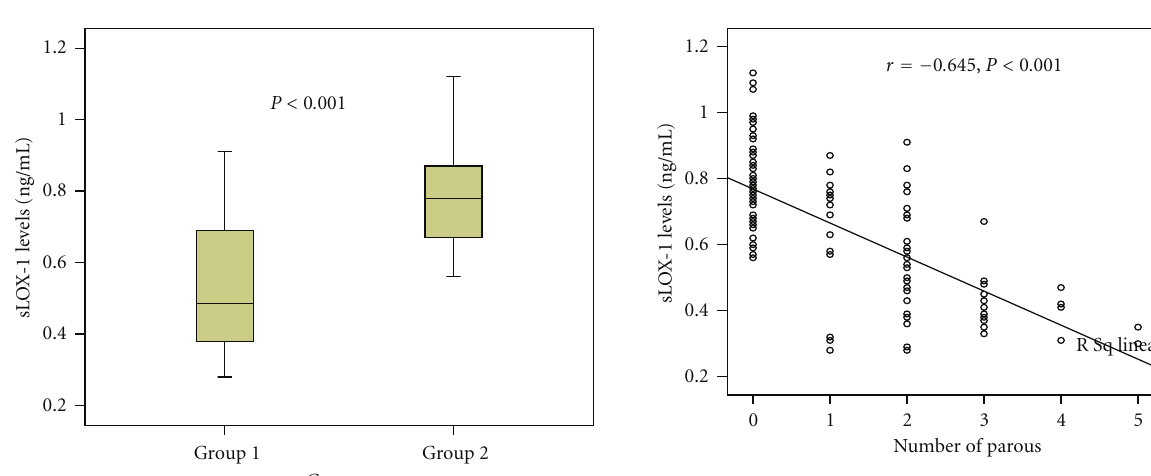
Figure 3: The correlation between sLOX-1 levels and number of